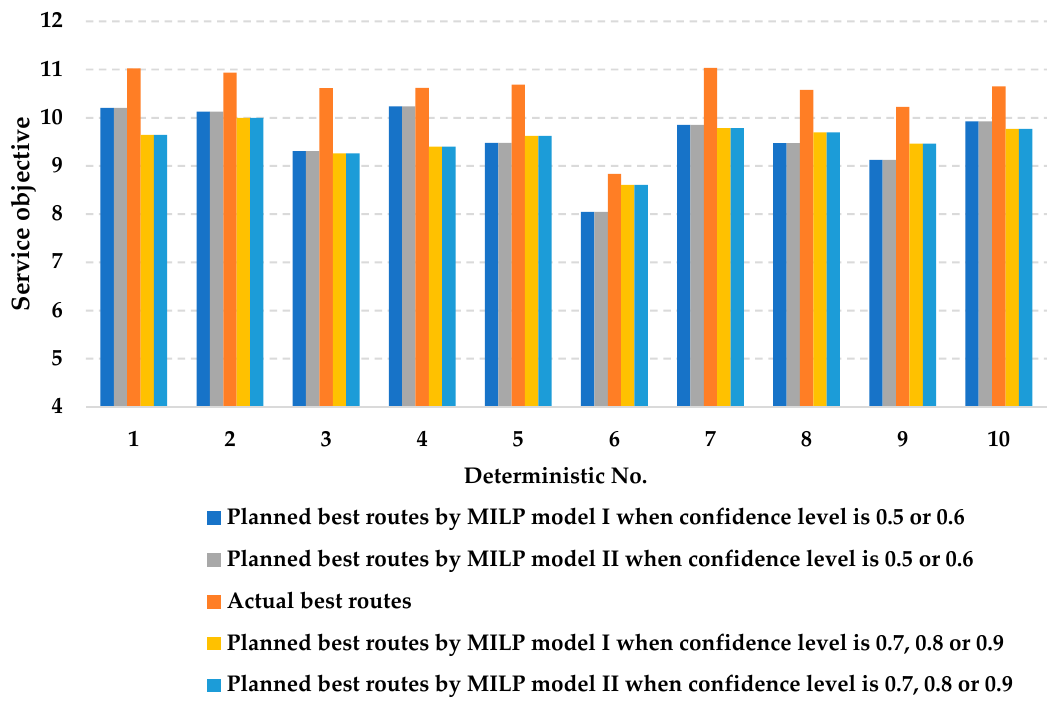
Figure 17. Economic objective gaps between the planned best routes given by the two MILP models and the actual best routes in the deterministic cases.